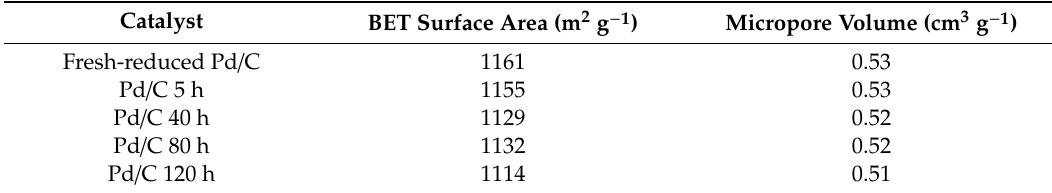
Table 2. BET Surface area and micropore volume of the